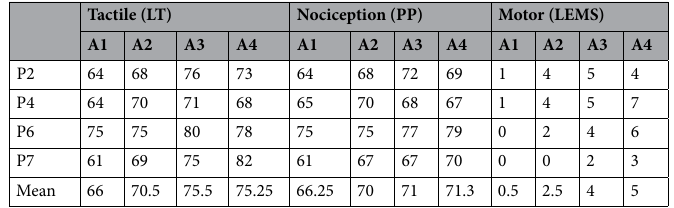
Table 2. Clinical scores for the L + B